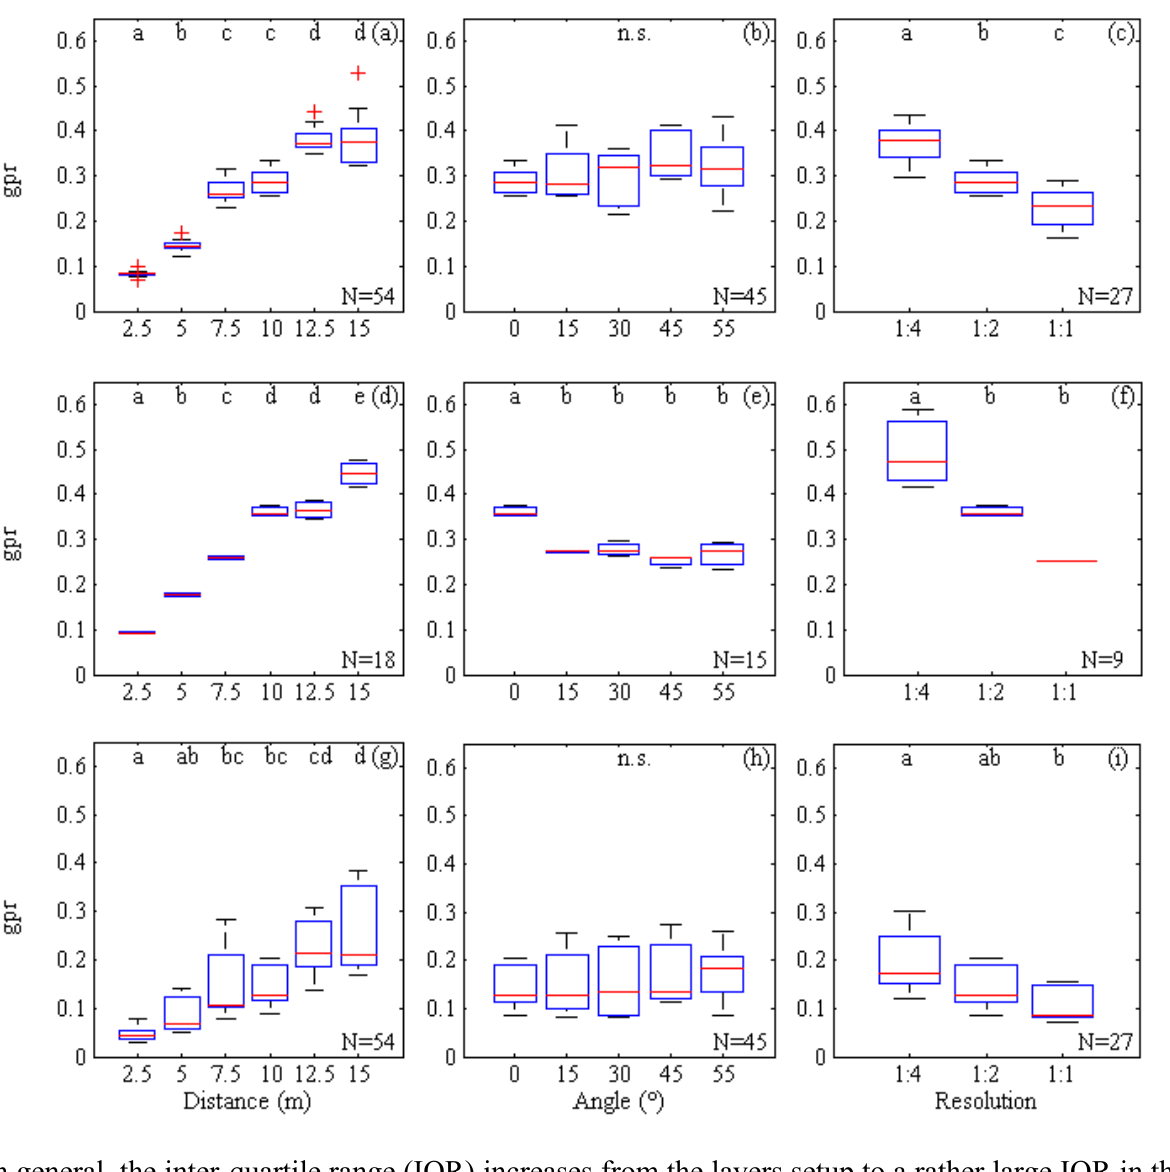
Figure 5. Boxplots displaying the distribution of ghost points ratio ( gpr ) by distance, angle and resolution. The box represents the interquartile range of the data (the 25th and 75th percentiles), and the whiskers represent the inner 10th and 90th percentiles. ( a – c ) the leaves setup; ( d – f ) the layers setup; ( g – i ) the branches setup. Box plots with different letters indicate significant differences between them (Tukey test, p < 0.05), and n.s. indicates differences that are not significant ( p > 0.05). Outliers are represented by plus (+)